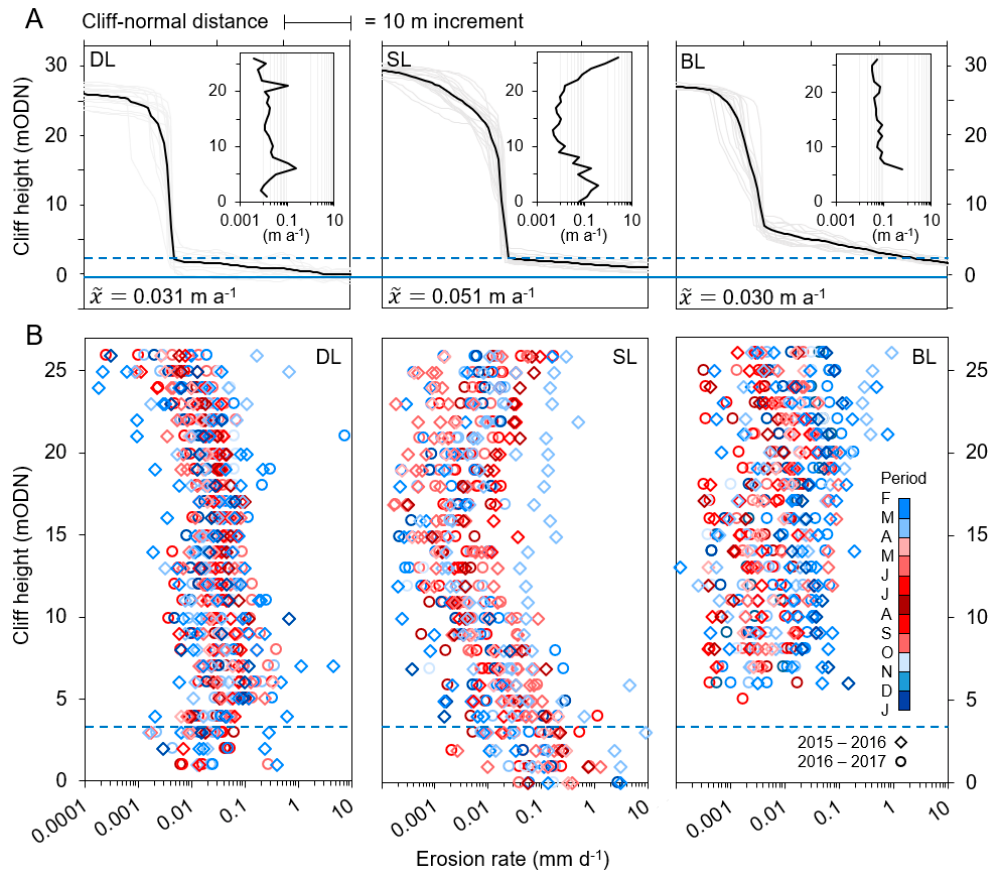
Figure 8. ( A ): Lithology-specific cliff-normal topographic profiles. Grey lines are individual profiles, extracted every 5 m of cliff line distance for representative sections of each unit. Black line shows mean profile. 𝑥(cid:3556) = mean erosion rate per lithology. Solid and dashed blue lines indicate position of mean sea level and the highest astronomical tide, respectively. Inset panels show mean erosion rate (x-axis for all = m a − 1 ) according to cliff height (y-axis; mODN). DL, SL, and BL are dolomitic, secondary, and brecciated limestone, respectively. ( B ): Temporal distribution of erosion rates across the cliff height. Data are classified by lithology and by differencing period for 1 m cliff height bins.